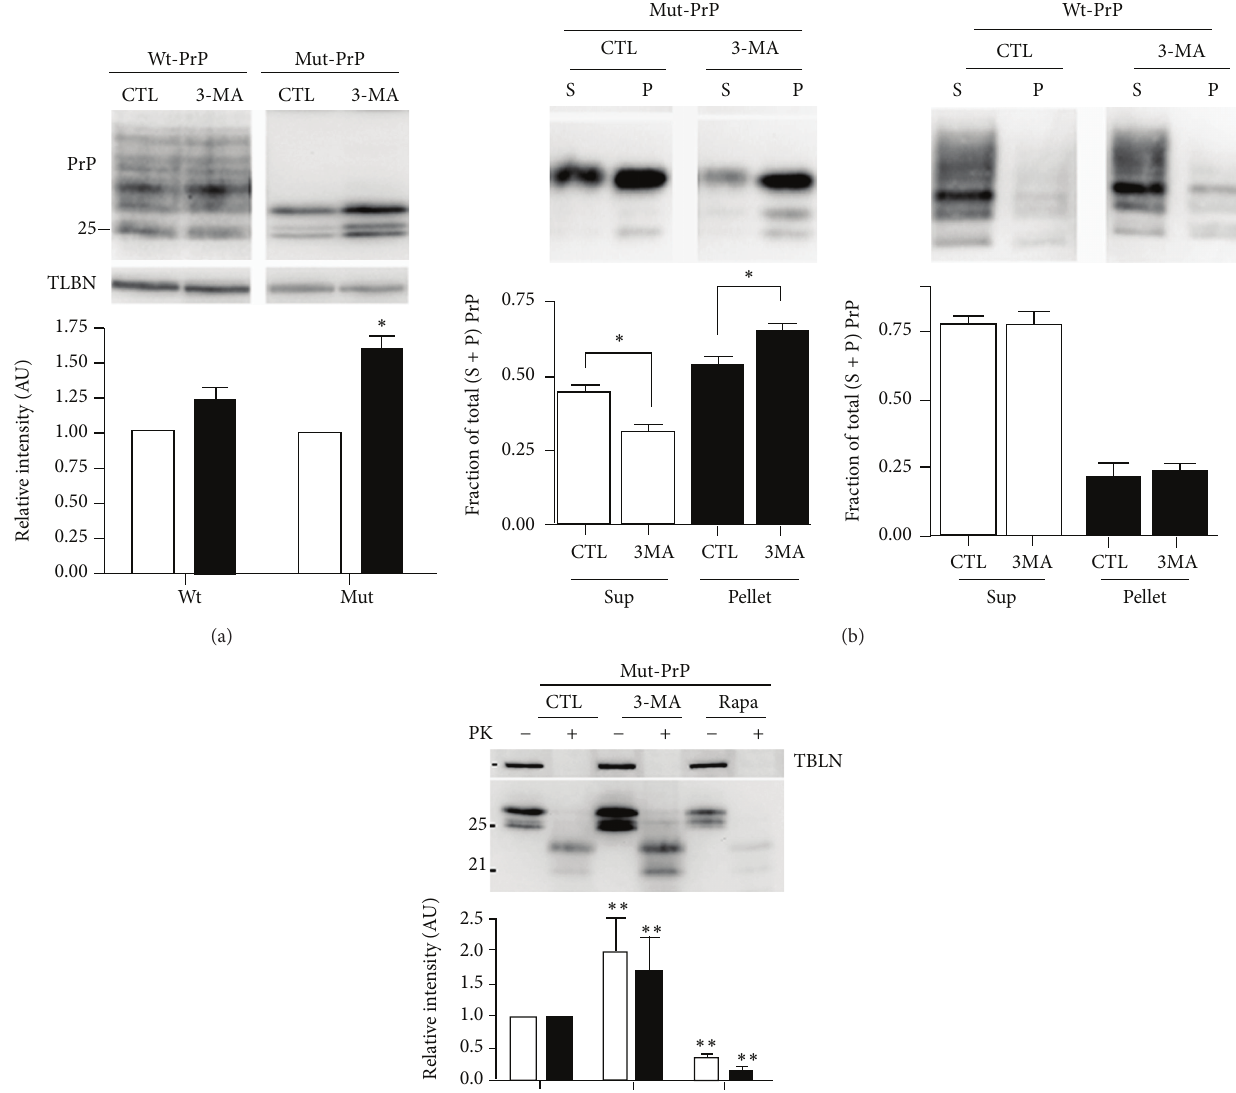
Figure 9: Autophagy is selective for insoluble/aggregated PrP. (a) Representative Western blot of total lysates from COS-7 cells transiently expressing Wt- or Mut-PrP (3F4) after 16h of incubation with 5mM 3-MA. The corresponding graph displays the relative densitometry of PrP signal before (open bars) and after (filled bars) 3-MA treatment ( ∗ 𝑃 < 0.05 , student’s paired 𝑡 -test, 𝑛 = 3 ). Tubulin (TBLN) is a loading control. (b) Representative Western blots of supernatant (S) and pellet (P) fractions of cells transiently expressing Mut or Wt PrP after 16h of vehicle (CTL) or 10mM 3-MA, and the corresponding graph from 3 experiments each. The insoluble (pellet) and soluble (sup) fractions of Mut-PrP are presented as the densitometric signal of each fraction over the sum of the two fractions (sup + pellet) ± SEM ( ∗ 𝑃 < 0.05 , 2-way ANOVA, Bonferroni posttest). (c) Cells transiently expressing Mut-PrP were treated for 6h with 10mM 3-MA or 20 𝜇 M rapamycin, harvested in lysis buffer, and digested with 5 𝜇 g/mL Proteinase-K (PK) for 15min at 37 ∘ C. Densitometry quantified as the intensity of each fraction (i.e., total PrP (open bar) or PK-resistant PrP (filled bar)), relative to their respective untreated normalized control fractions ( ∗∗ 𝑃 < 0.005 ANOVA, Bonferroni post test, difference from CTL, 𝑛 = 3 experiments).